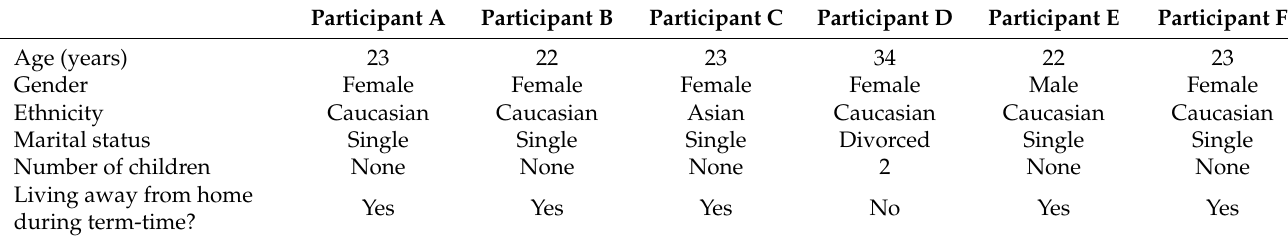
Table 2. Characteristics of the participants of the study.